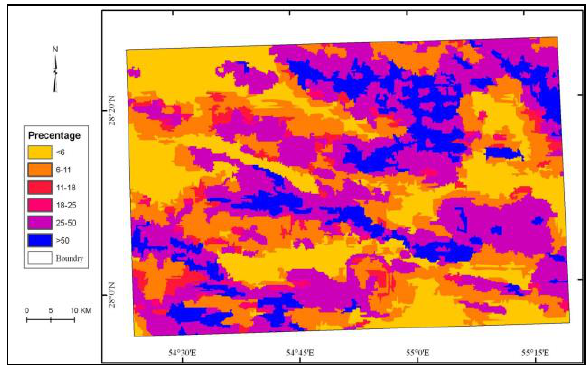
Figure 2. Slope map of study area